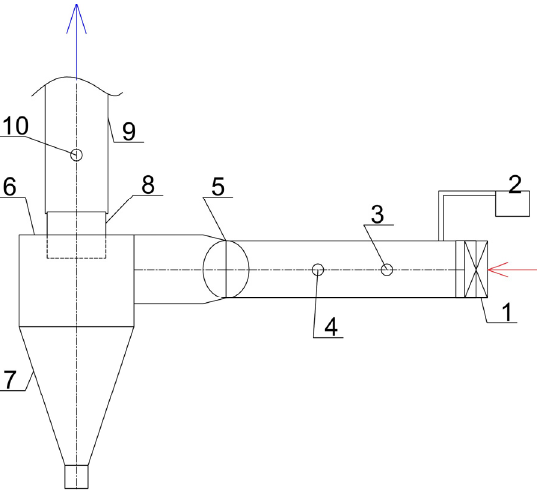
Figure 2. An experimental electro cyclone bench with (1) air flow fan, (2) particle dispenser, (3) air flow rate/pressure test point in the contaminated flow duct, (4) particle number concentration point in the duct, (5) duct transition to mixer, (6) cyclone-filter part of the purifier, (7) hopper of the purifier, (8) electrostatic filter part of the purifier, (9) outlet duct of the purified air, (10) test point of the air flow rate/pressure of the contaminated in the flow duct.